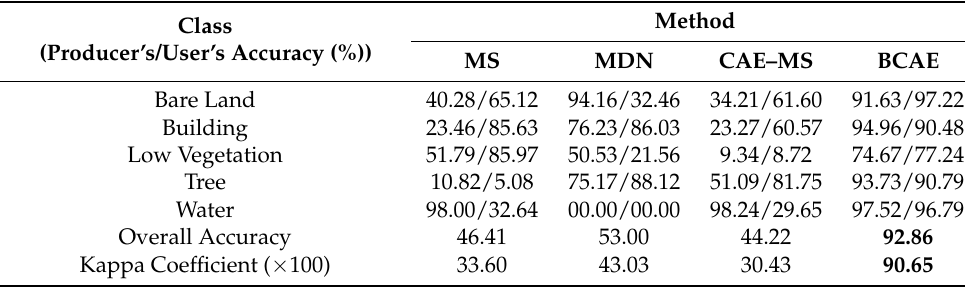
Table 11. A comparison between the clustering results of the Vaihingen dataset.